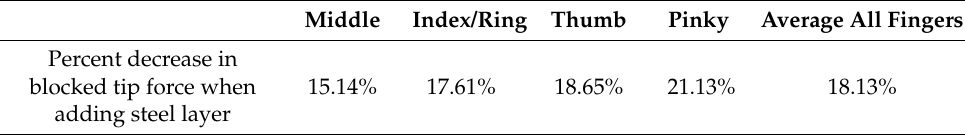
Table 2. Percent decrease in blocked tip force when adding steel layer.